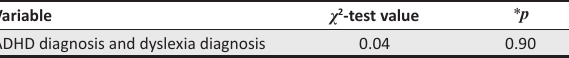
TABLE 3: Relationship between attention deficit hyperactivity disorder and developmental dyslexia diagnoses. Variable